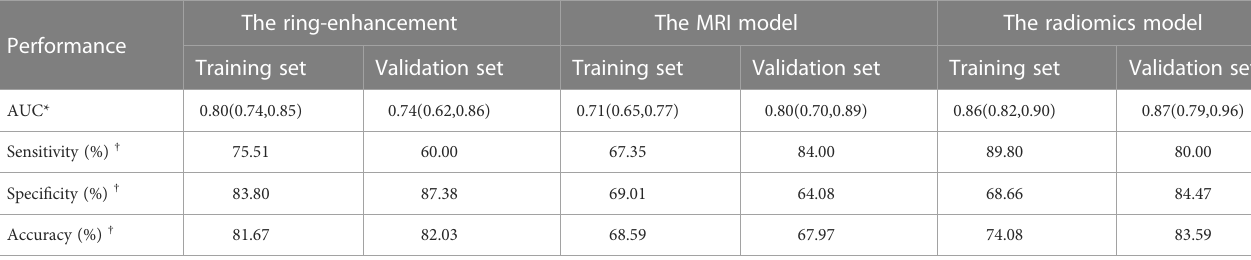
TABLE 4 The Performance of the Prediction